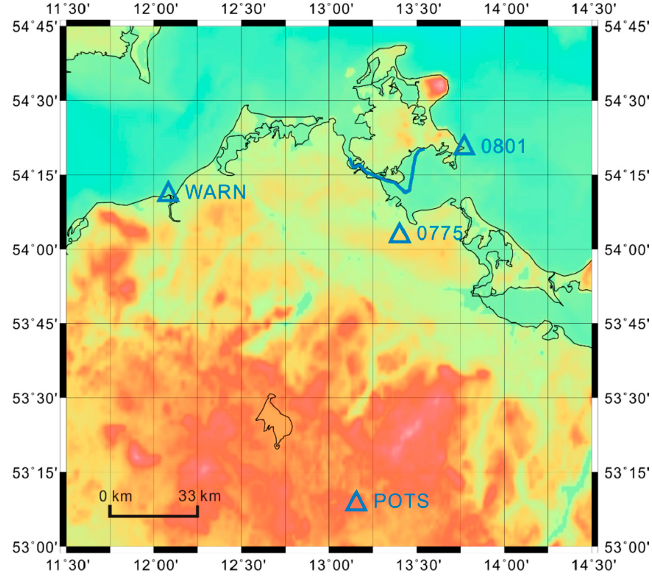
Figure 3. The trajectory of the ship (blue curve) and the positions of all reference stations (blue triangles) of the Baltic Sea shipborne gravimetric campaign on 18 June 2013. Table 1. Hardware equipment of the chosen stations from the Baltic Sea gravimetric campaign.